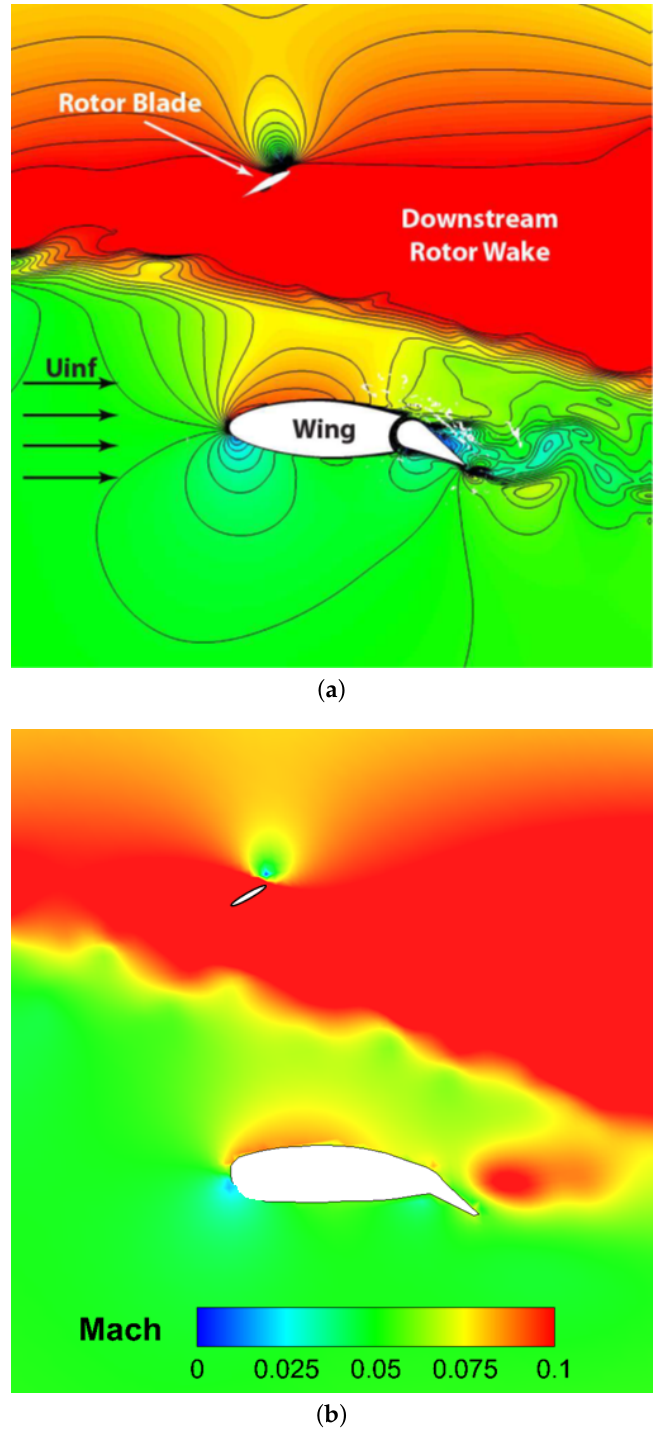
Figure 18. Comparison of the instantaneous flow field at wing midspan in conversion flight condi- tions at ψ = 270 ◦ , θ N = 75 ◦ , V ∞ = 40 kts, Ω = 589 RPM. ( a ) CFD-[16]; ( b ) DUST. Nacelle angle θ N = 60 ◦ , freestream velocity V ∞ = 100